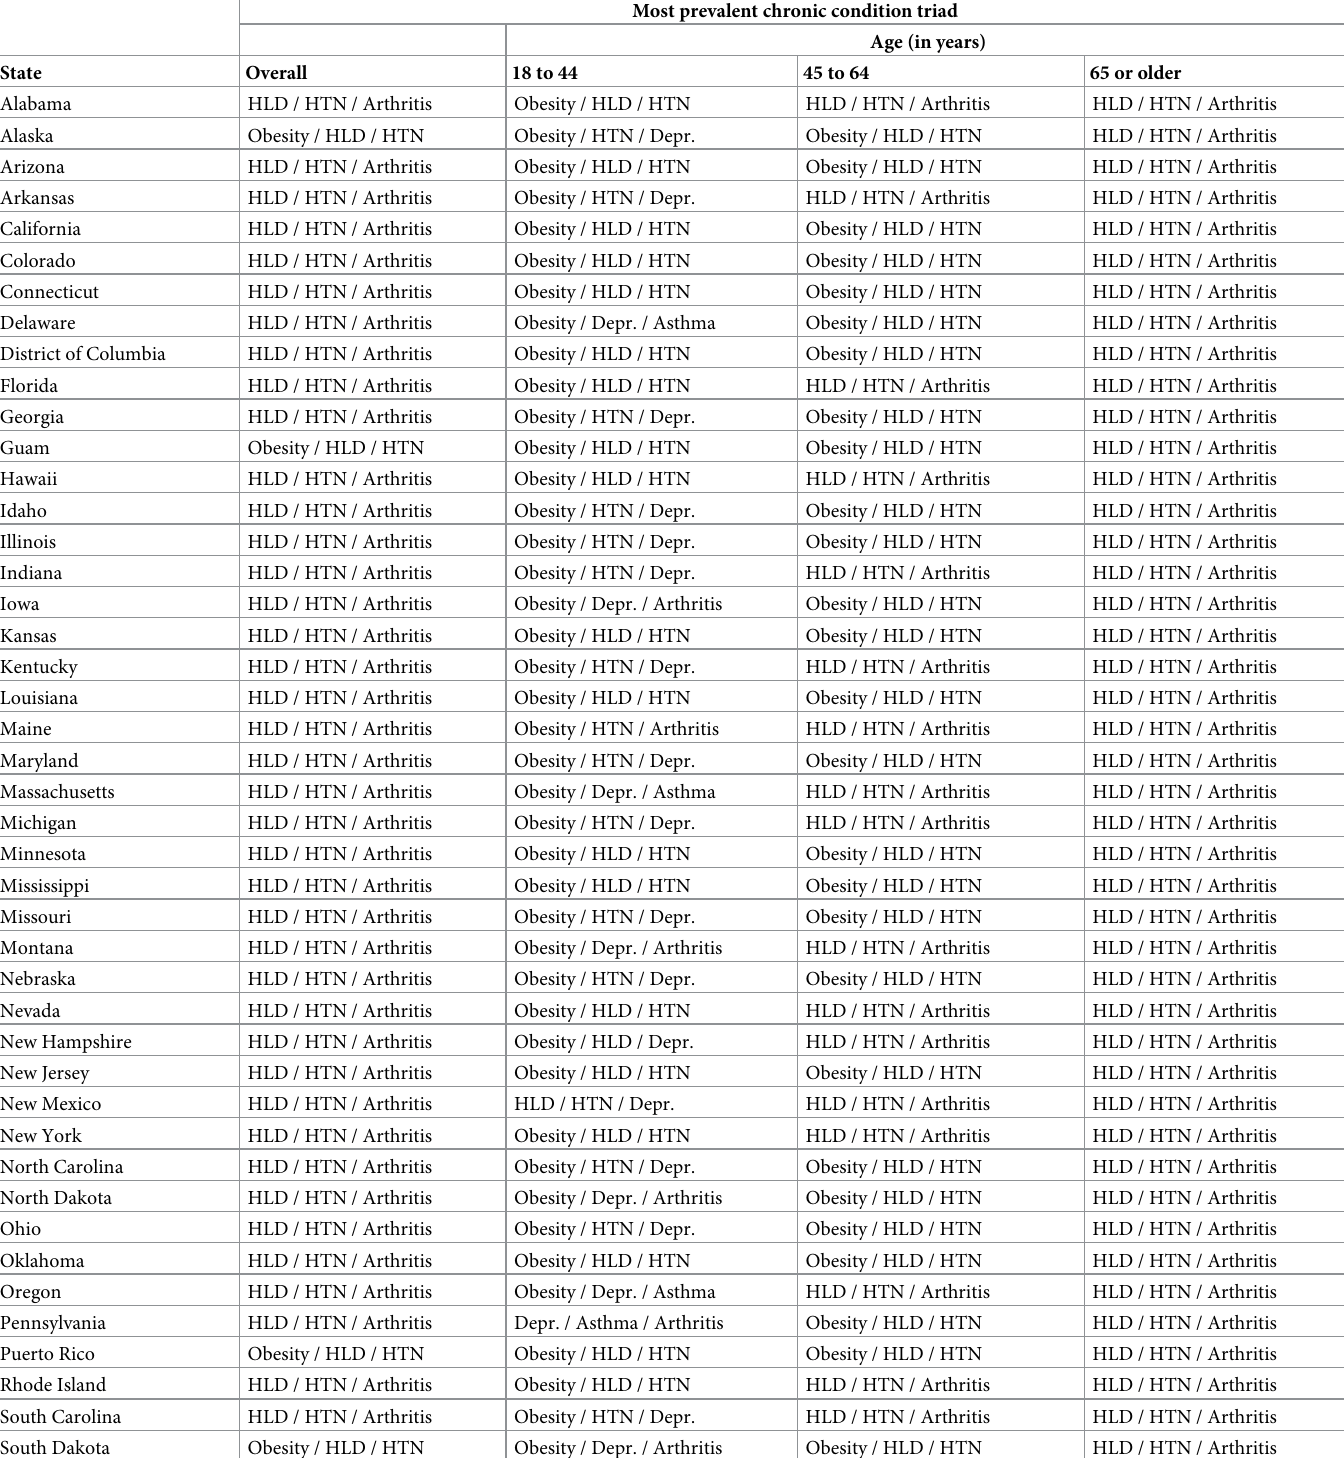
Table 3. Most prevalent chronic condition triads among adults aged � 18 years, by state or territory and age—Behavioral Risk Factor Surveillance System, United States,